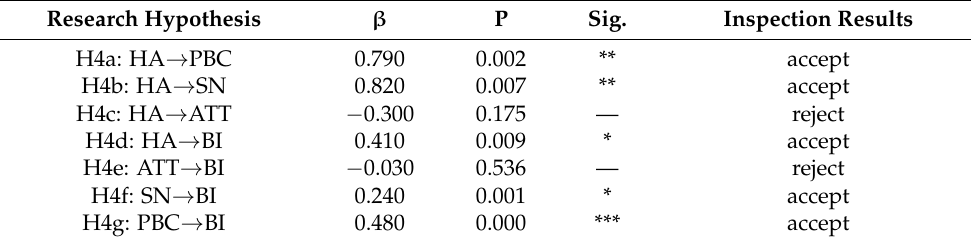
Table 5. Hypothesis test results of structural equation